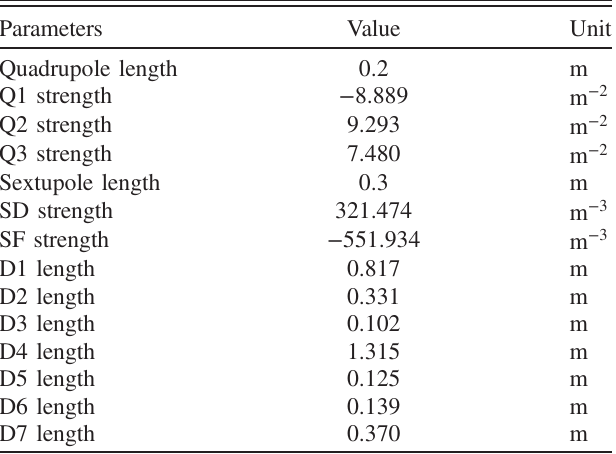
TABLE IV. Lattice parameters of Solution II.